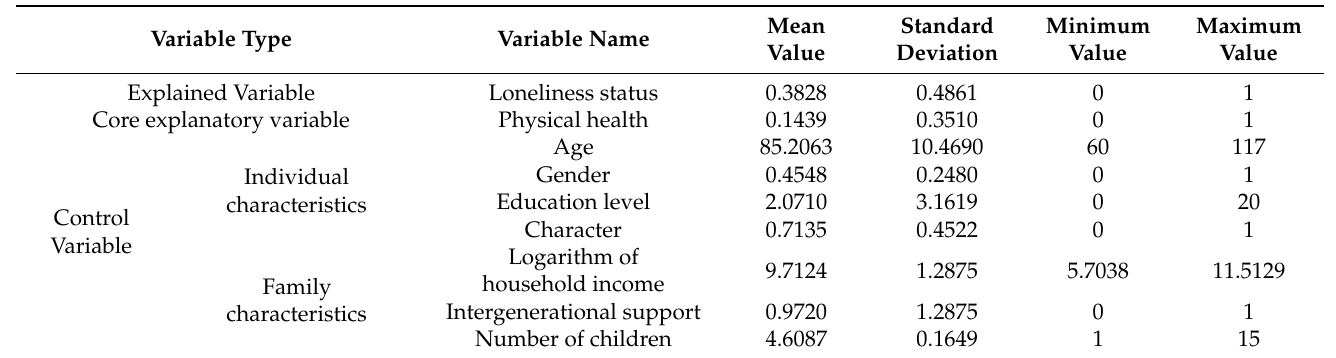
Table 2. Statistical results of variables.